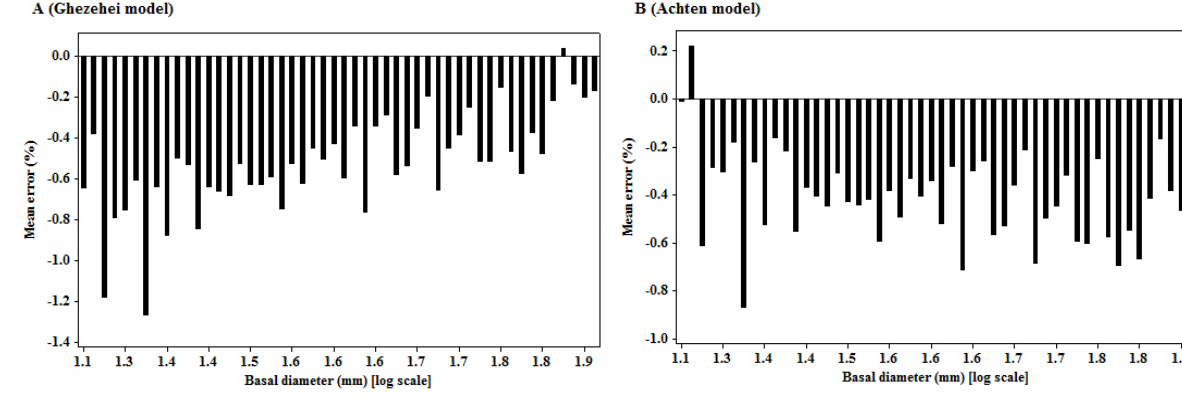
Figure 4. Distribution of prediction errors based on Ghezehei et al. ( A ) and Achten et al. ( B )